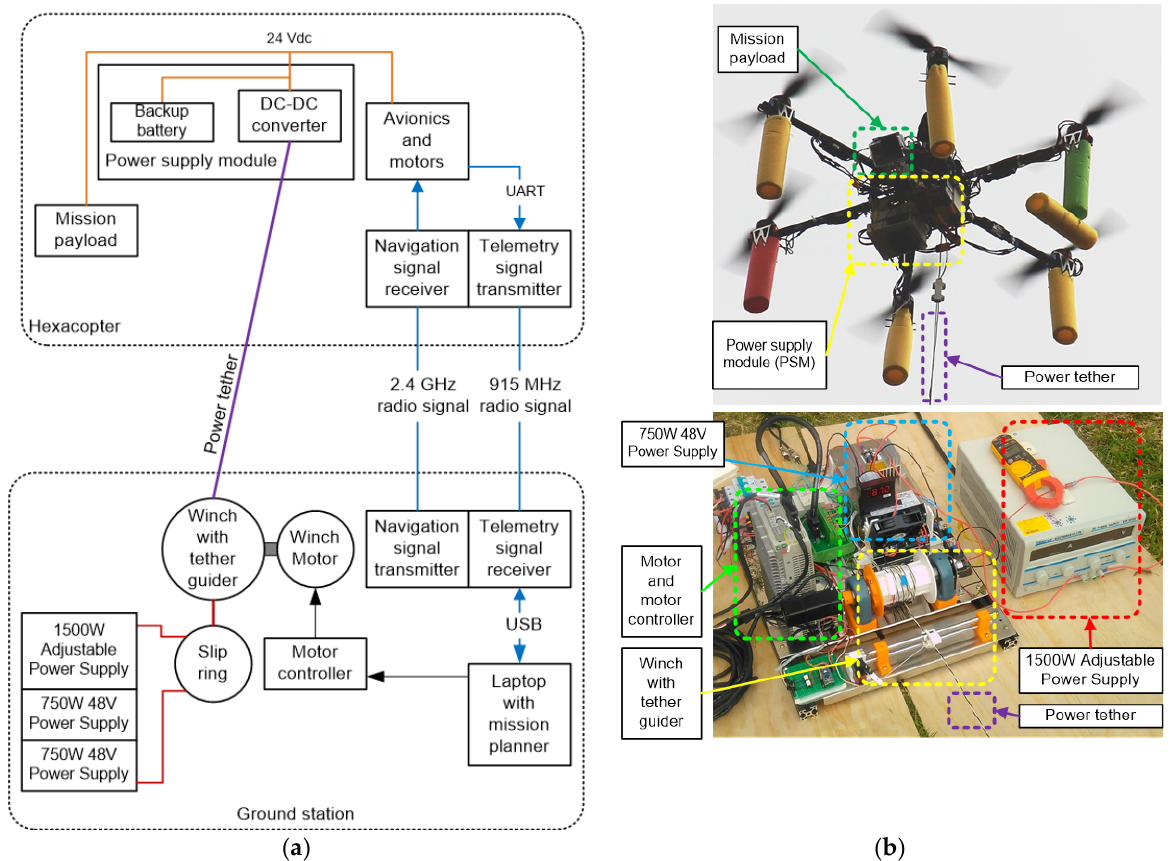
Figure 1. ( a ) System diagram of Tether-powered hexacopter; ( b ) Photos of hexacopter and ground station.